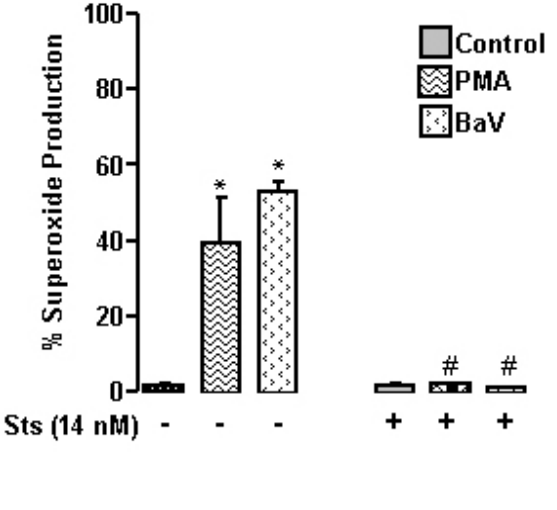
Figure 6. Effect of PKC inhibition on superoxide production by thioglycollate-elicited macrophages. Thioglycollate-elicited macrophages were incubated with BaV (6 mg/mL) or RPMI (control) in the presence or absence of staurosporine (Sts – 14 nM/mL, 15 minutes), followed by addition of RPMI, 0.1% NBT, 10 μL of PMA (500 ng/mL) (positive control) for the formation of formazan crystals resulting from the reduction of NBT by superoxide. Cytospin slides were stained with safranin and 200 cells were counted under light microscope and expressed as percentage of positive cells for superoxide. Values are mean ± SEM from four animals. * p < 0.05 compared to controls, # p < 0.05 compared to BaV without staurosporine